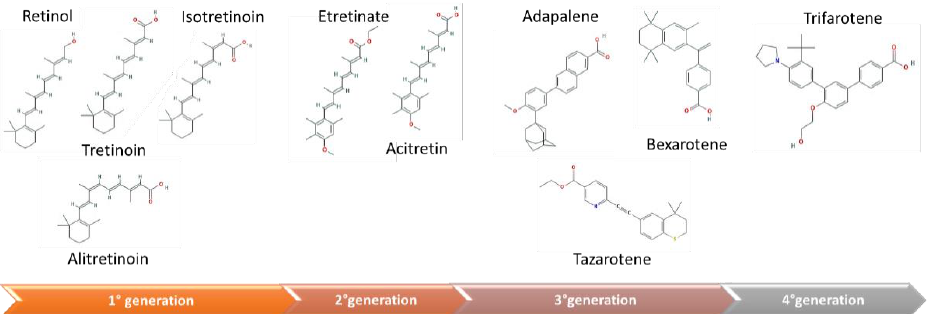
Figure 2. Molecular structure of retinoids divided per generation. The first generation is composed by natural retinoids, obtained modifying polar groups of vitamin A (retinol, tretinoin, isotretinoin, and alitretinoin). The second generation is constituted by monoaromatic compounds, in which a benzene ring replaces the cyclohexene ring (etretinate, and acitretin). The third generation is made up by polyaromatic molecules, resulting from the cyclization of a side chain (adapalene, bexarotene, and tazarotene). Trifarotene is a recently synthetized fourth-generation retinoid, highly specific for skin RAR-γ receptors (References in supplementary materials).